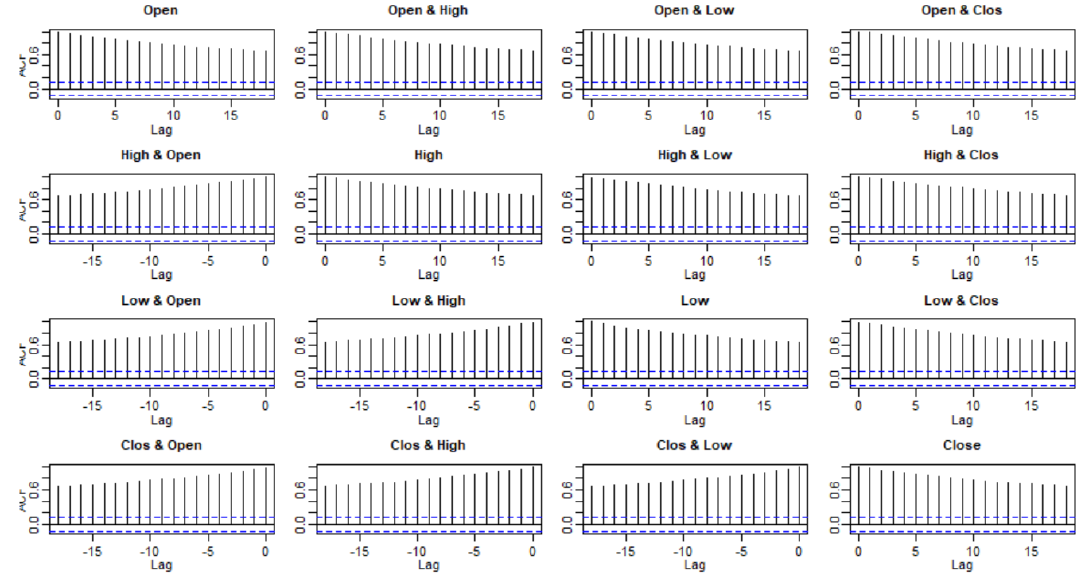
Figure A1. ACF test for correlation between open, low, high, and close of Facebook daily stock